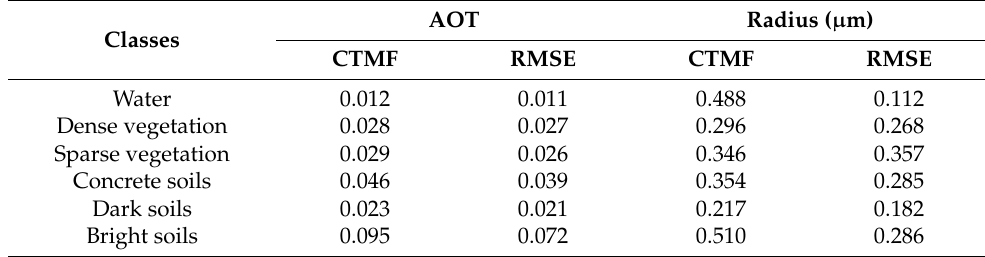
Table 4. Mean AOT and radius by class of soil, retrieved with the CTMF and RMSE